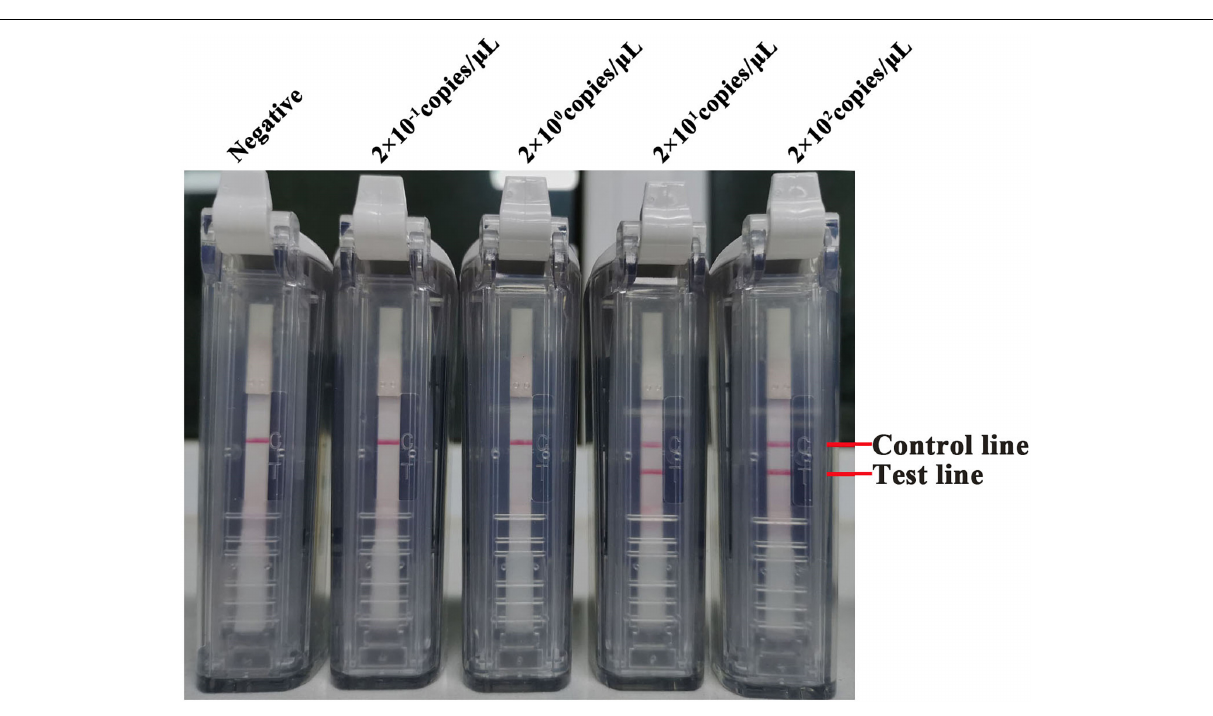
FIGURE 4 | The sensibility of the RT-LAMP-VF assay targeting the N gene. The limit of detection of the RT-LAMP-VF assay using 10-fold serially of SARS-CoV-2 RNA